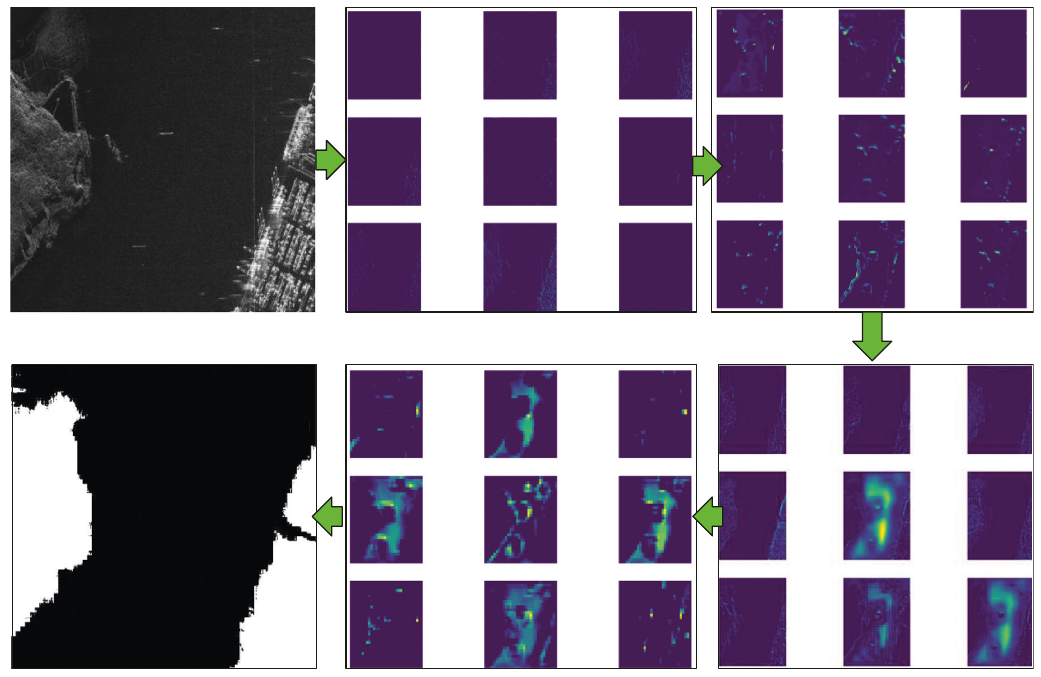
Figure 16: The extracted feature maps for a SAR